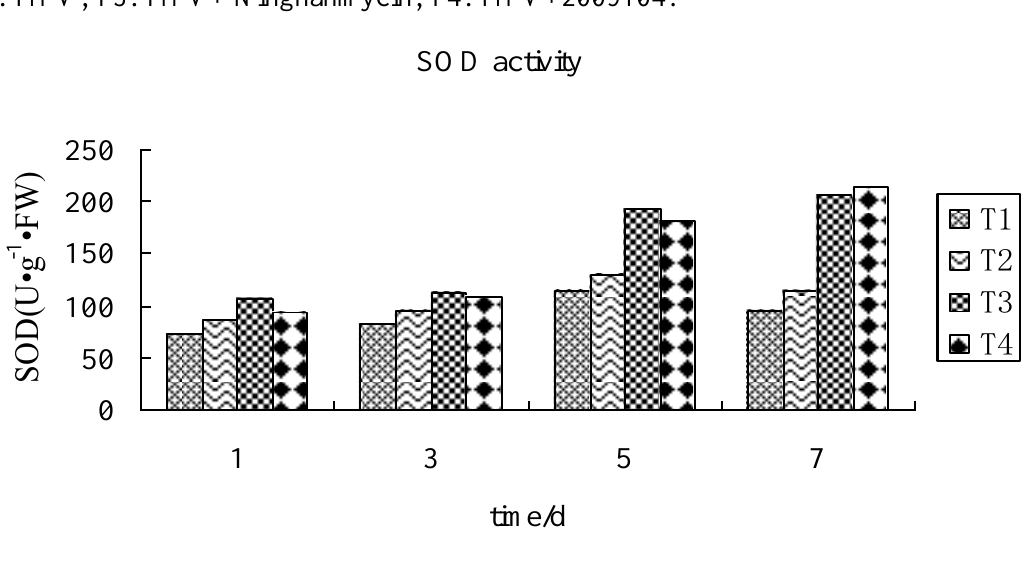
Figure 5. SOD activity in tobacco leaves in differential treatment groups T1: